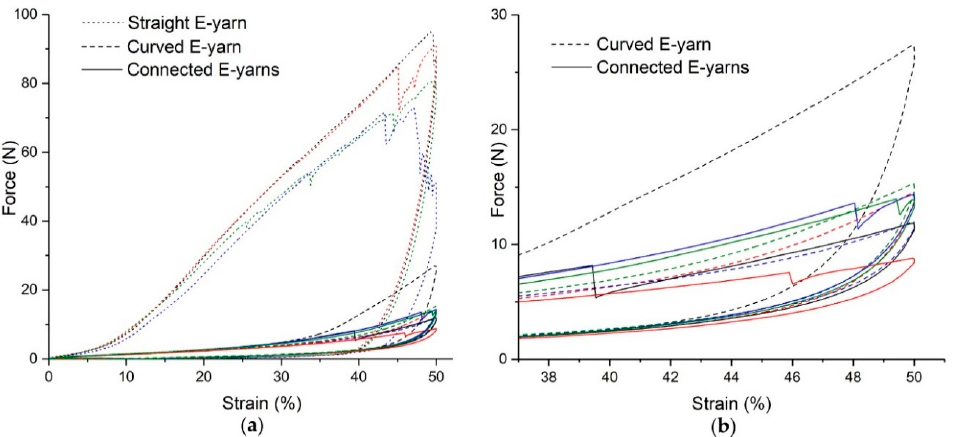
Figure 8. Results from the first cycles of cyclic tensile testing of the E-yarns attached to stretch fabric: ( a ) Notches near the top of the dotted curves show failure of straight E-yarns attached to stretch fabric; ( b ) The dashed lines in this detail from ( a ) show how E-yarns attached to the samples in a curved pattern remained intact. Notches in the solid lines show breakages in connections between curved E-yarns.